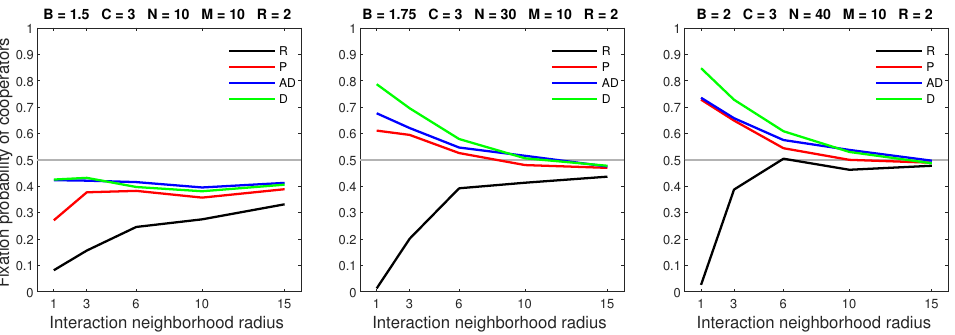
Figure 20. Breakdowns in cooperation only occur in the random and probabilistic dispersal